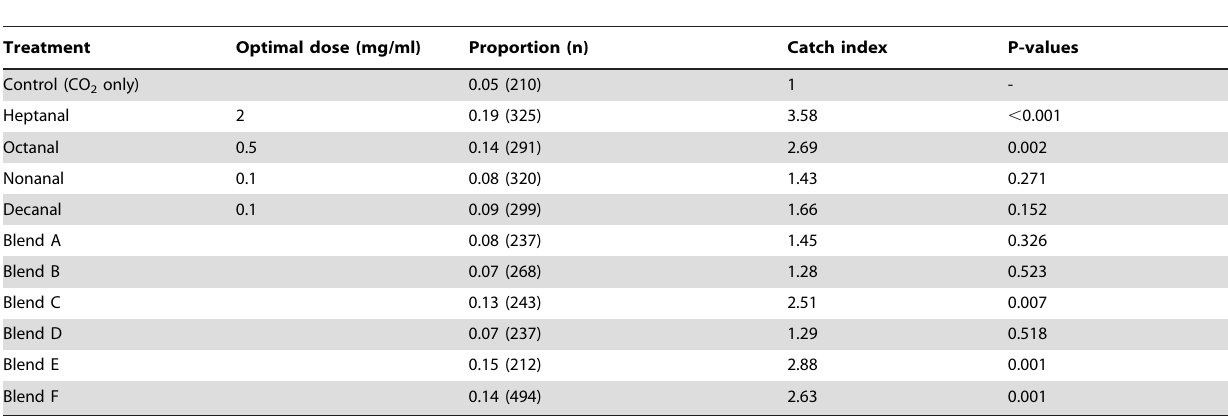
Table 3. Proportion of total engorged RVFV mosquito (blood fed + gravid) of total captures recorded in control traps (CO 2 only) and combined lures having CO 2 and optimal single compounds/blends evaluated and corresponding catch